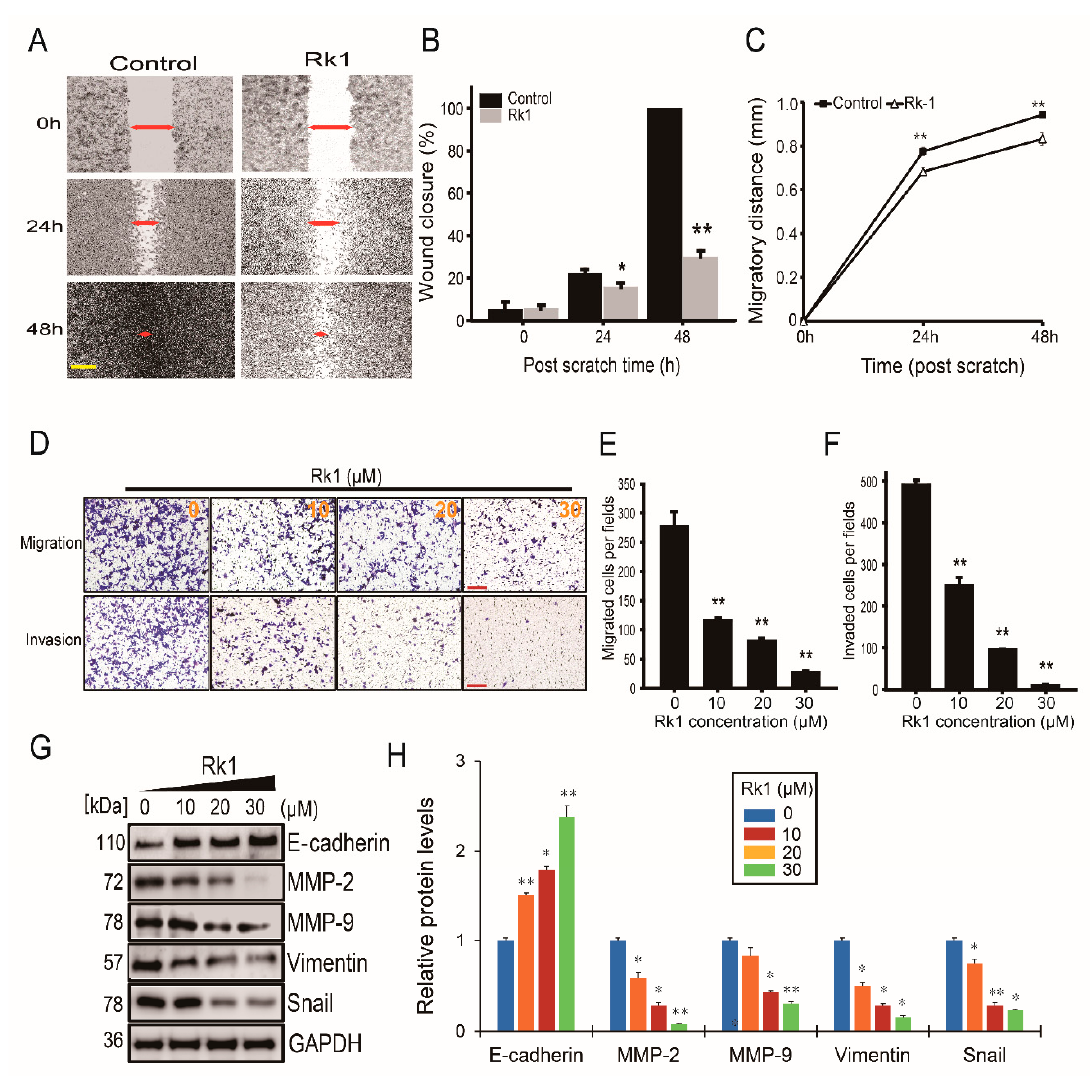
Figure 5. Rk1 inhibits EMT in SK-N-BE(2) cells. ( A ) Cell mobility was investigated by wound healing assay. Representative images from in vitro wound healing assays demonstrated that cell migration into the cell-free region (outlined) was significantly suppressed in the presence of Rk1, as compared to the control. Magnification of the images: 200 × . Scale bar: 200 µ m. ( B , C ) Bar graph illustrates percent wound closure ( B ) and migratory distance ( C ) was measured at 0 h, 24 h, and 48 h after cells were scratched. ( D – F ) Migration and invasion ability was analysed by transwell assay with non-coated membrane (upper panel) or with Matrigel-coated membrane (lower panel). ( D ) Magnification of the images: 100 × . Scale bar: 100 µ m. The migration ( E ) and invasion ( F ) of SK-N-BE(2) cells were significantly decreased in Rk1-treated groups. ( G , H ) The level of EMT-related proteins in SK-N-BE(2) cells was examined by western blot. Bar graphs in ( B ), ( C ), ( E ), ( F ), and ( H ) represented as